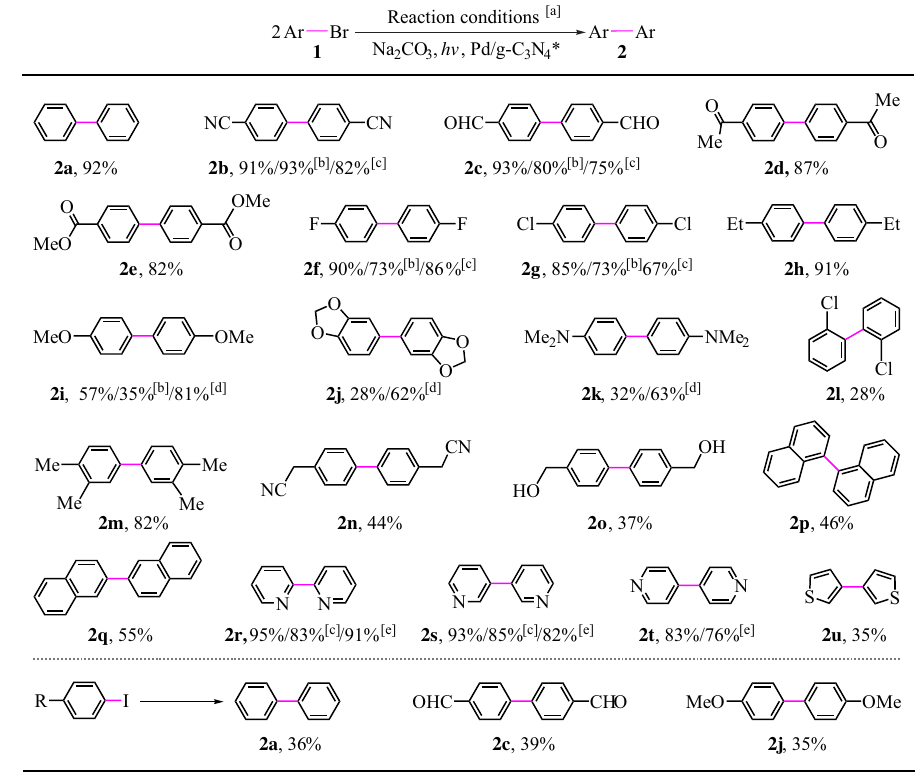
420±10nm LED (incident light intensity: 0.15W/cm 2 ), all the data shown in this fi gurearethe isolatedyieldsunlessotherwise speci fi ed; b 10h, GC yield; c incident light intensity: 0.10 W/cm 2 , GC yield; d 365±10nm LED; e 3h, GC